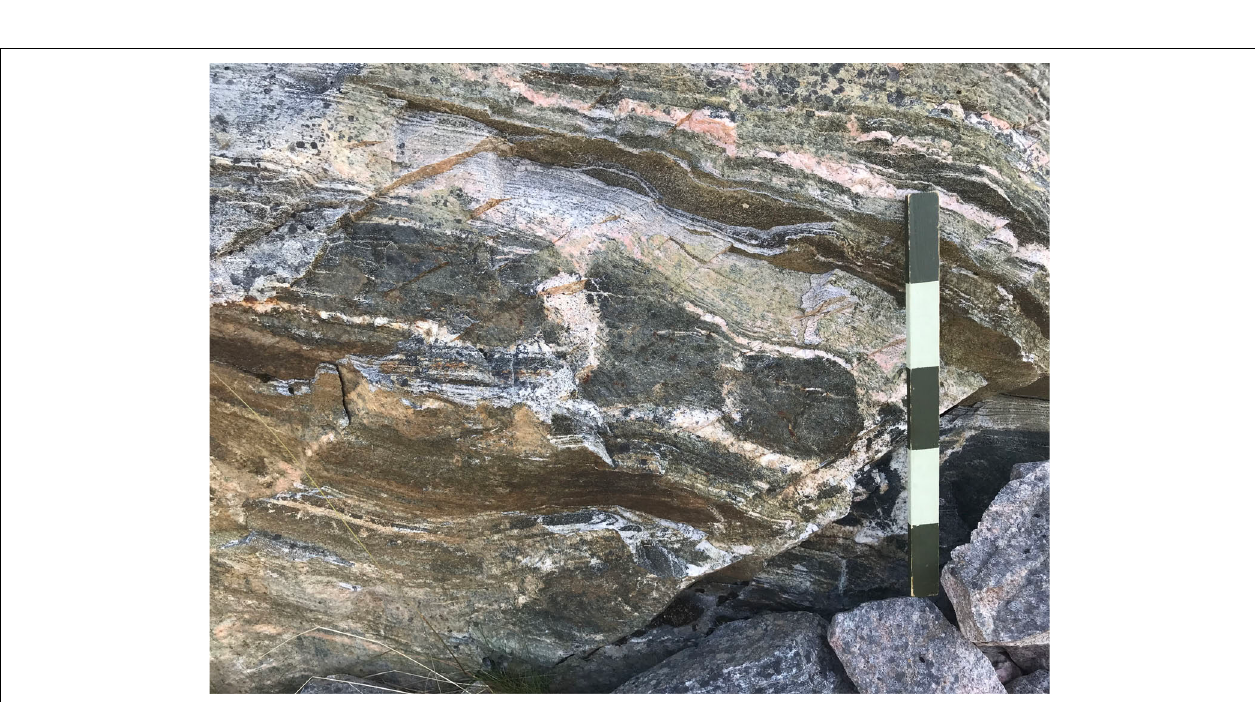
FIGURE 8 | Dilation structures and layered (stromatic) metatexite, Kvaløya, northern Norway, West Troms Basement Complex. Length of scale 50 cm.